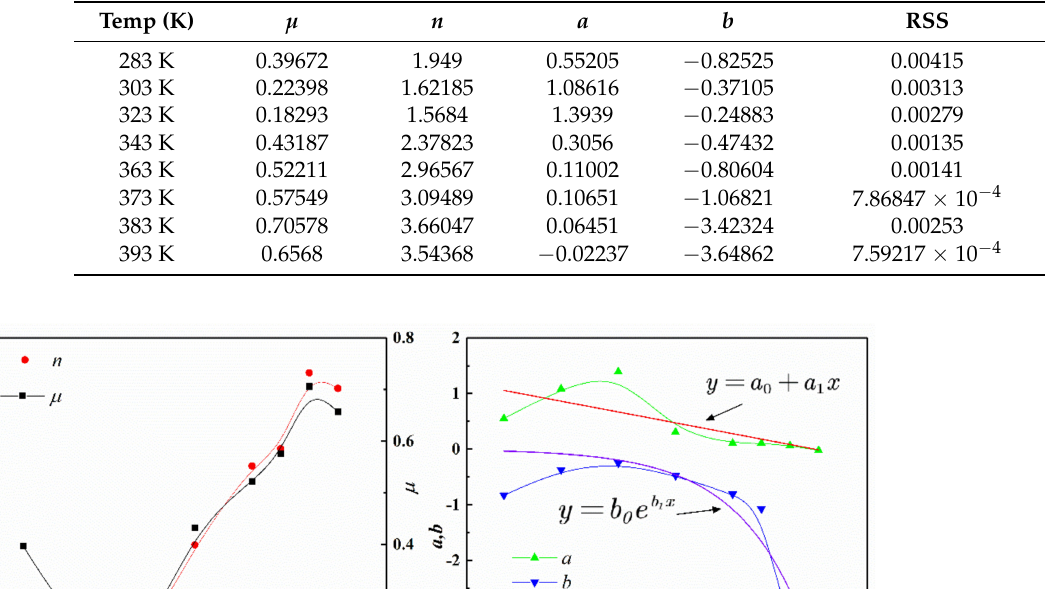
Table 5. Fitting parameters of the improved eight-chain model to test data of the filling rubber NR-1 at different temperatures.